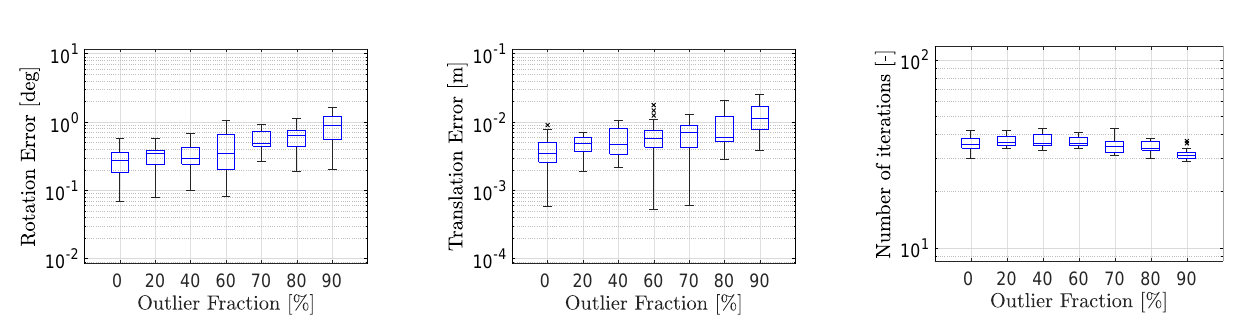
Figure 4: Box plots showing rotation errors, translation errors, and number of iterations used for Point cloud reg- istration using the Stanford Bunny data set, solved using Dynamical Pose Estimation with Graduated Non-Convexity.